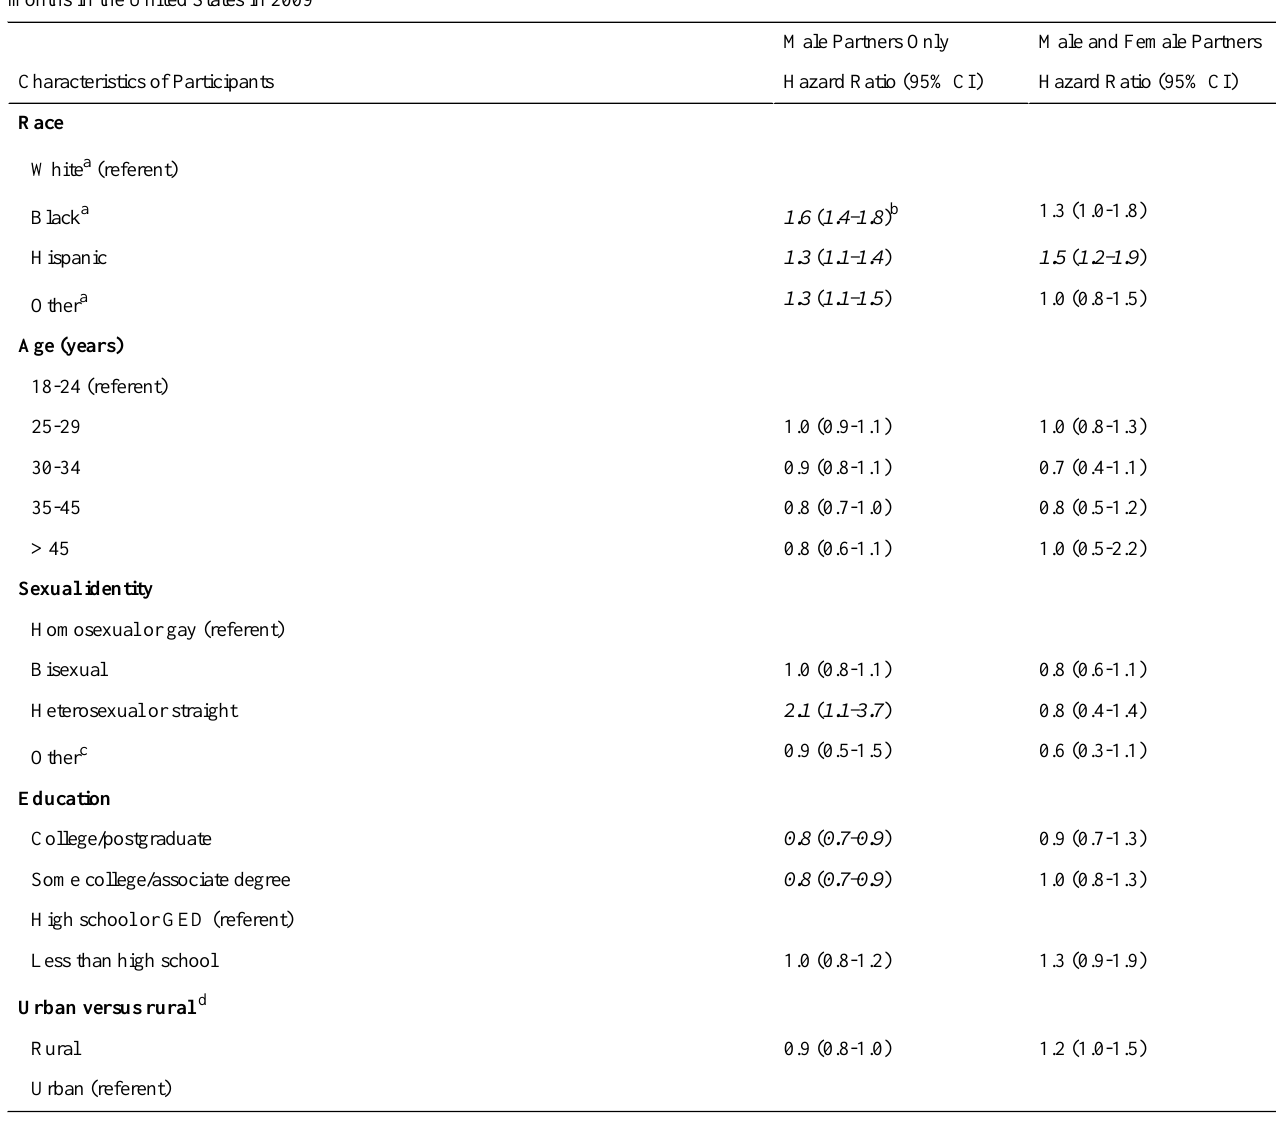
Table 4. Hazards of failure to complete all pages of an online HIV behavioral risk survey, by gender of sexual partners of participants in the past